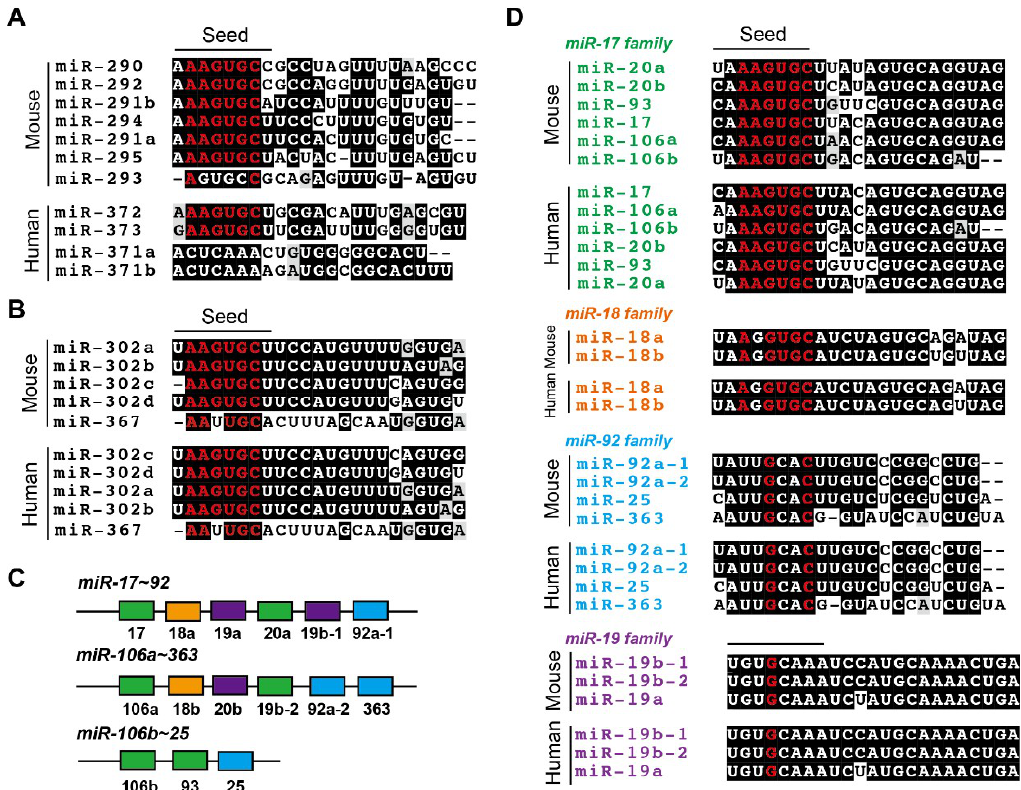
Figure 3. Major miRNA clusters expressed in embryonic stem cells. ( A ) Mouse miR-290~295 cluster and human miR-371~373 are homologous miRNAs. Except for miR-293 in mice and miR-371 in humans, all miRNAs contain the “AAGUGC” motif in seed sequences (marked in red). ( B ) The sequence alignment of mouse and human miR-302~367 clusters, which are highly conserved and also contain the “AAGUGC” motif. ( C , D ) The structure and sequence alignment of miR-17~92, miR-106a~363 , and miR-106b~25 clusters. Please note that the miR-17 family contains the full “AAGUGC”, while the miR-18, -19 , and -92 families only contain a part of the “AAGUGC” motif.